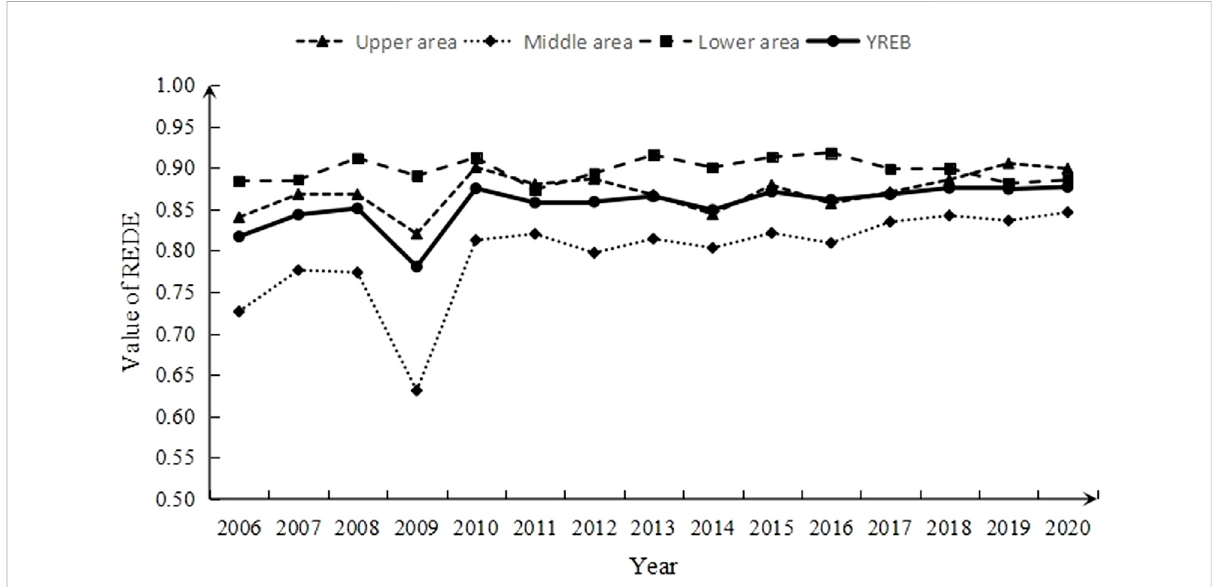
FIGURE 3 Change trend of the eco-ef fi ciency of RED in the study region from 2006 to